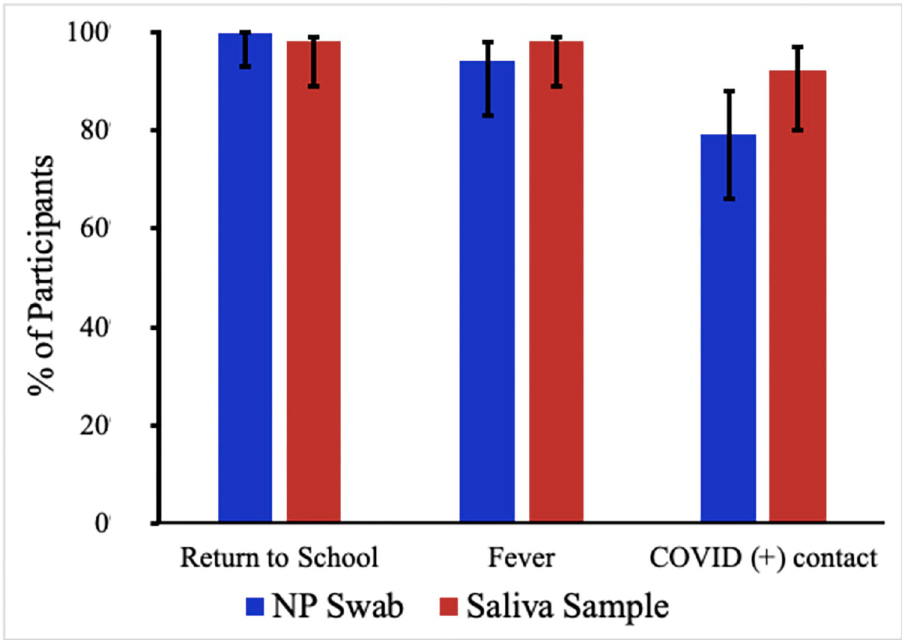
Fig 1. Percentage of participants responding they would be likely to want COVID-19 testing, based on the sampling method and scenario proposed.